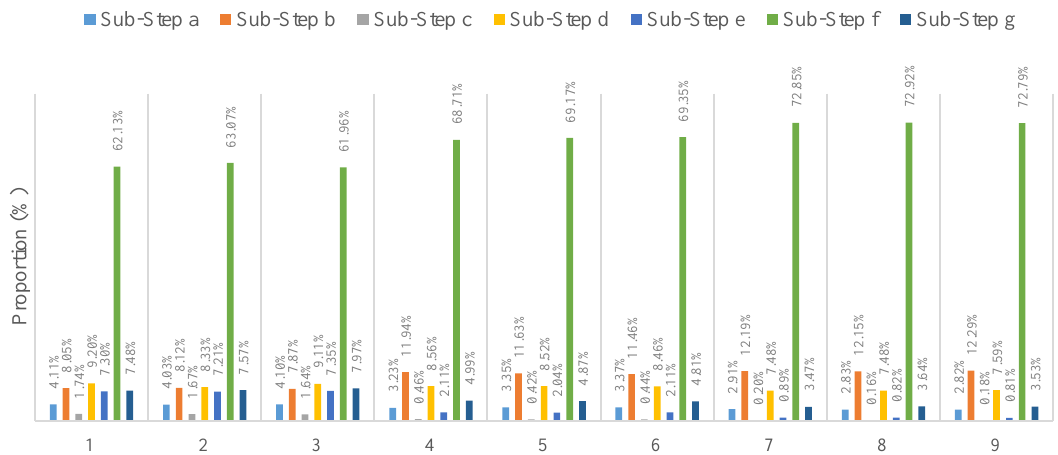
Figure 7. Time consumption by each sub-step in the universal kriging function.